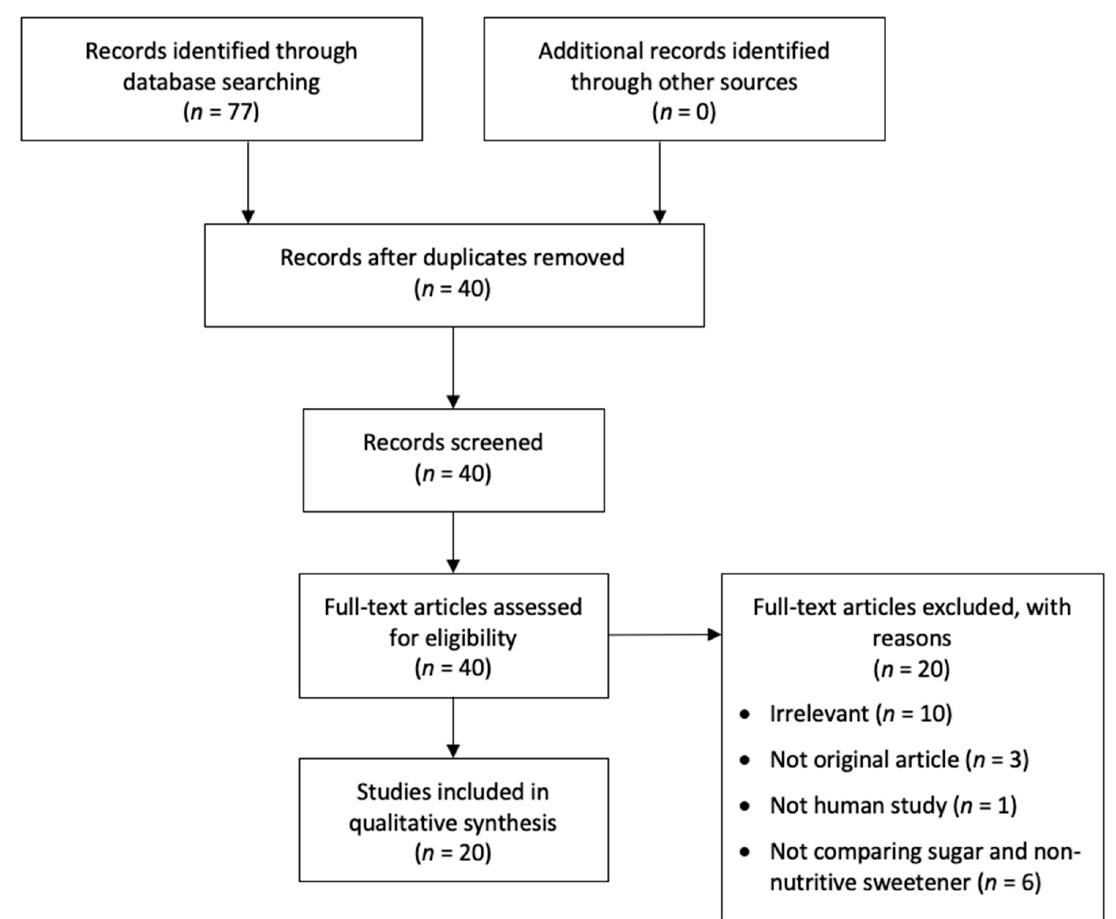
Figure 1. Diagram for literature search.